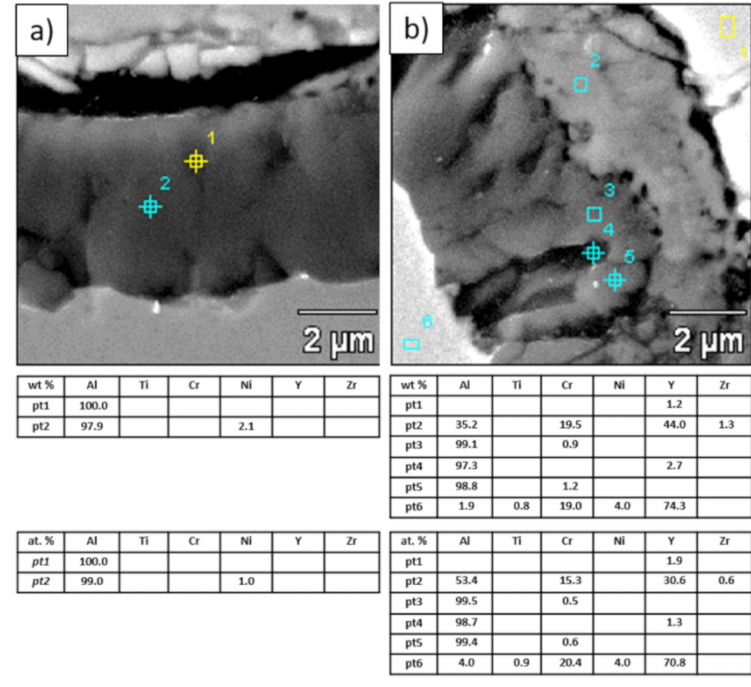
Figure 21. Analysis of chemical composition in micro-areas of the TGO zone after 500 h of oxidation at a temperature of 1100 ◦ C—composite 50% La 2 Zr 2 O 7 + 50% 8YSZ TBC (SEM): ( a ) zone of the bond-coat bottom and ( b ) zone of the bond-coat